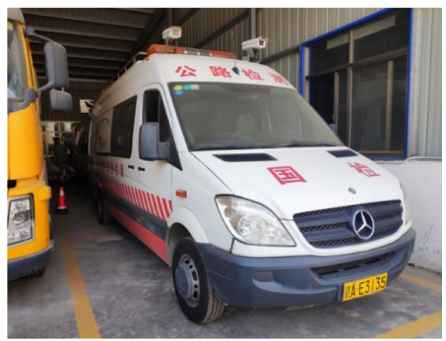
Figure 1. Road inspection